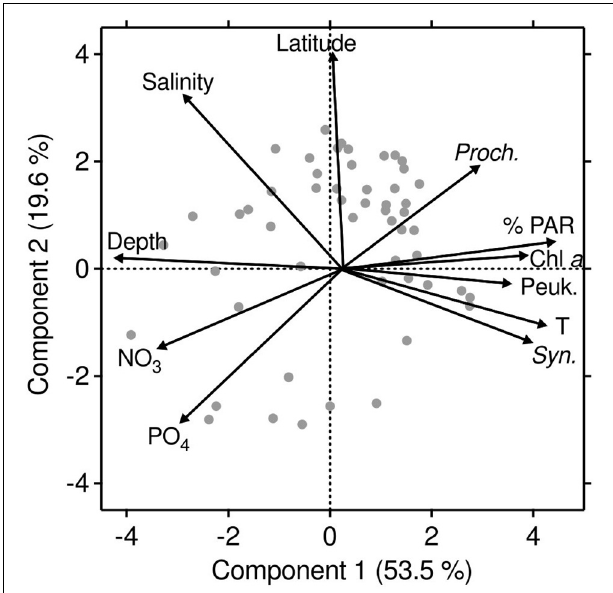
FIGURE 5 | Principal-component analysis (PCA) of the first two components, summarizing the distribution of Synechococcus , Prochlorococcus , and picoeukaryotes with respect to geographical and environmental parameters (latitude, depth, temperature, salinity, chlorophyll a , %PAR, NO 3 , and PO 4 ) in the Red Sea. Principal component 1 explained 53.5% of the variability and showed a positive correlation with picophytoplankton abundances, temperature, %PAR, and chlorophyll a concentration, as well as a negative correlation with depth, nutrient concentration, and salinity. Principal component 2 (19.6% of variability) was positively correlated with latitude, salinity, and Prochlorococcus abundance and negatively with nutrients and Synechococcus